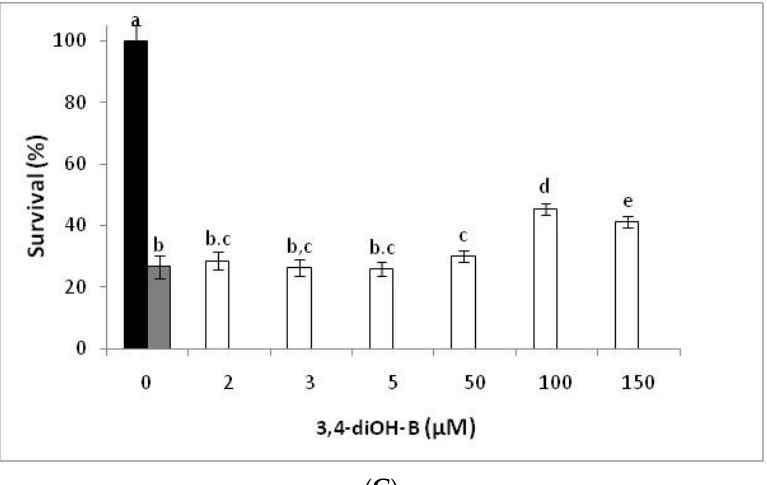
Figure 1. Effect of the tested phenolic compounds on survival rates of S. cerevisiae BY4741 cells treated with H 2 O 2 (5 mM). Black bar means untreated cells, gray bar means cells treated only with H 2 O 2 , and white bars mean cells treated with H 2 O 2 + 2,3-diOH-BA ( A ), 3,4-diOH-BA ( B ), and 3,4-diOH-B ( C ). Data represent the mean values ± SD of at least three independent experiments. Different lowercase letters above the bars indicate a statistically significant difference at p < 0.05.